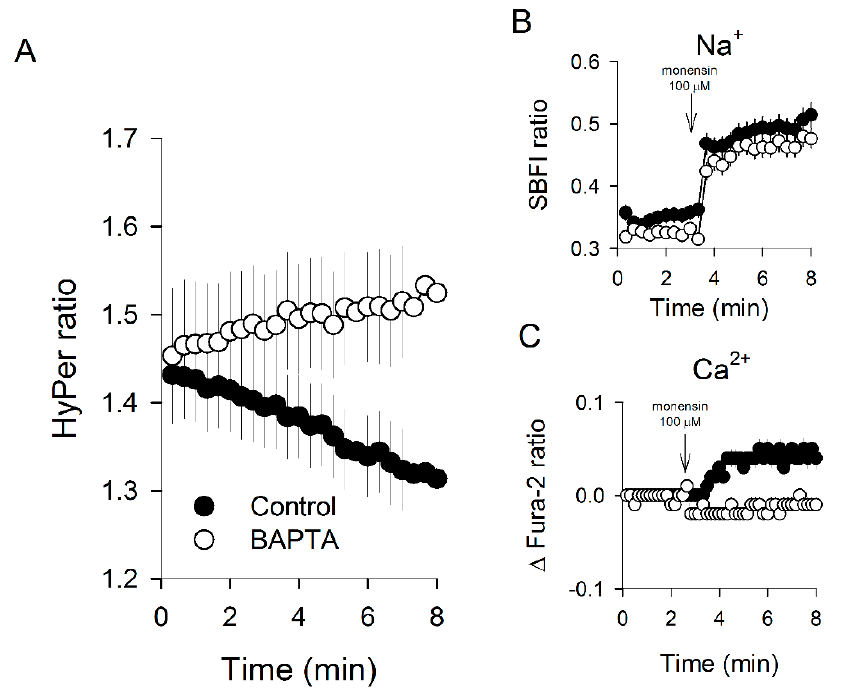
Figure 5. Cytosolic calcium increment is necessary to observe a monensin-induced HyPer signal decrease in Caco-2 cells. ( A ) HyPer signal obtained 2 min after addition of 100 µ M monensin in control Caco-2 cells (filled circles) and in cells loaded with 75 µ M BAPTA (open circles). Data are expressed as the average ± SE of 18 control cells and 15 BAPTA-loaded cells from three independent experiments. ( B ) Cytosolic sodium increment was measured in Caco-2 cells by means of SBFI imaging; data correspond to the average ± SE of 58 control cells from four experiments (filled circles) and 32 cells from three experiments treated with BAPTA (open circles). ( C ) Changes in the fluorescence ratio of Fura-2 were recorded for 61 control cells from four experiments (filled circles) and 35 cells loaded with BAPTA from three experiments (open circles). Data correspond to the average ± SE; the addition of 100 µ M monensin in ( B ) and ( C ) is indicated by arrows on the plots.